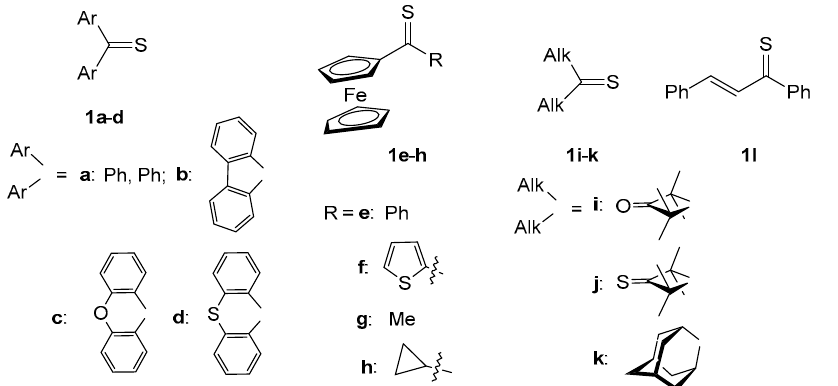
Figure 1. Synthetically useful representatives of aromatic 1a–d ; ferrocenyl 1e–h ; cycloaliphatic 1i– k ; and α , β -unsaturated 1l